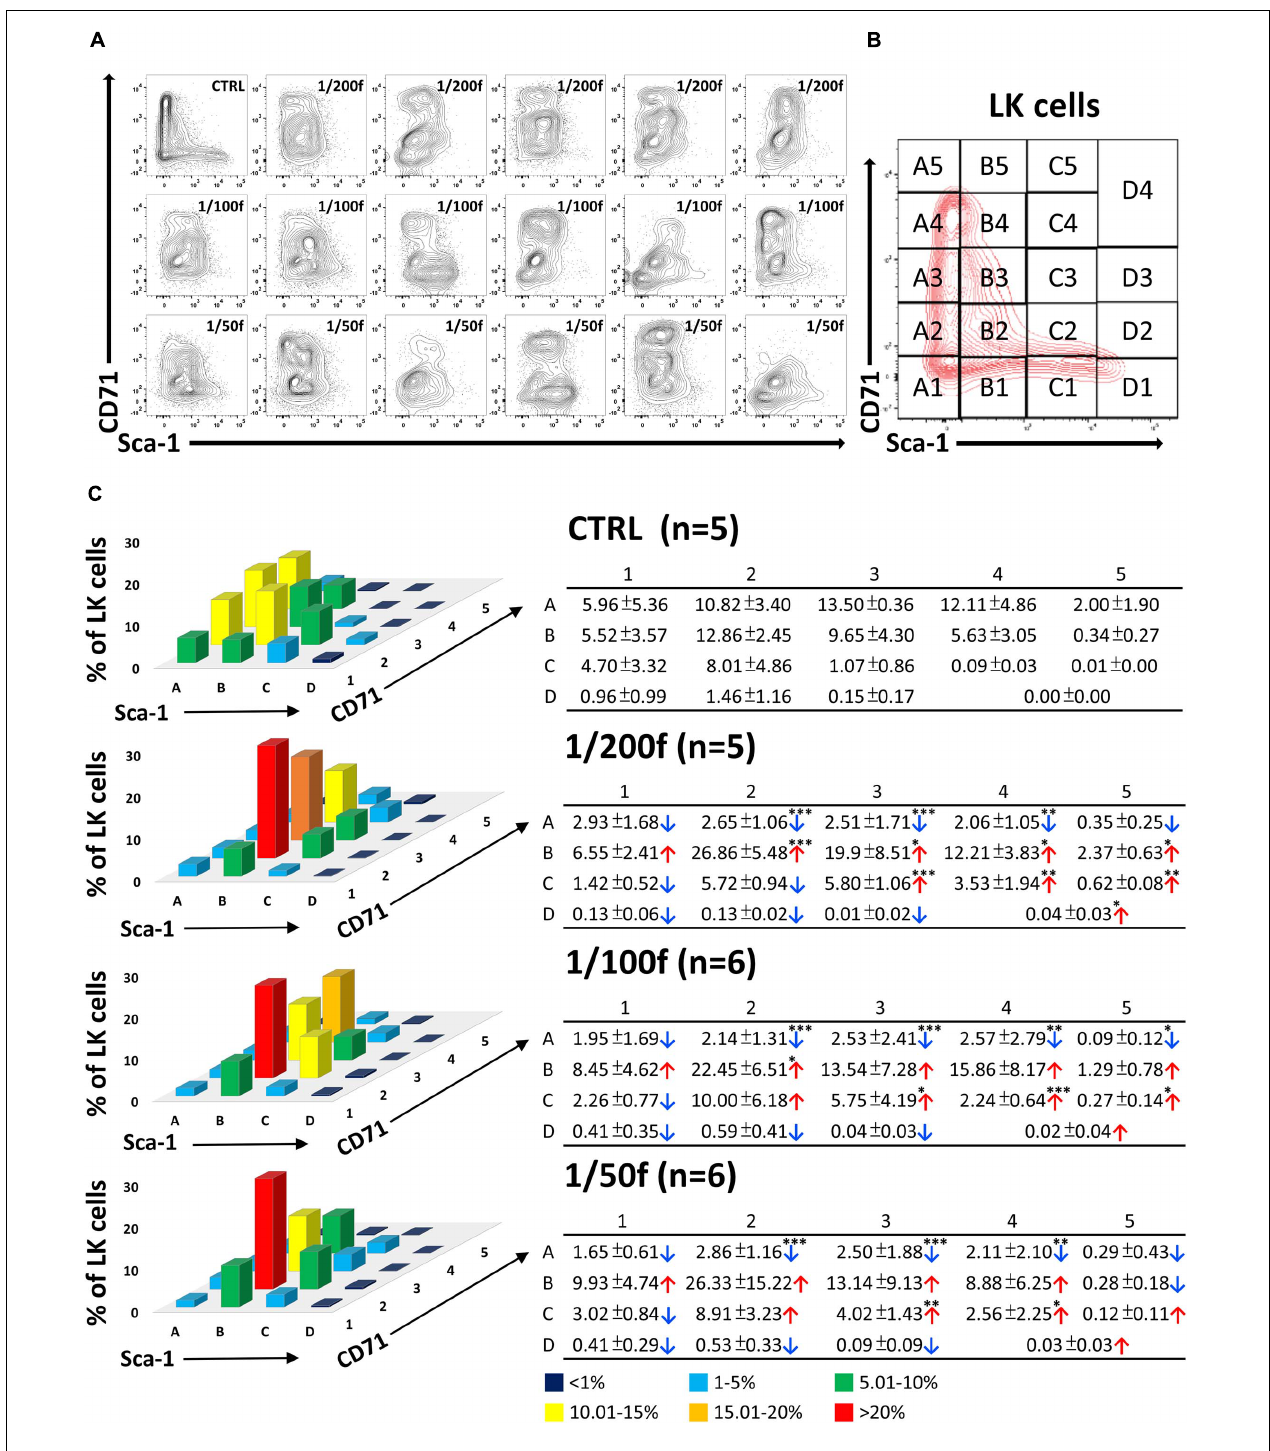
FIGURE 2 | Immature hematopoietic cells derived from transplanted bone marrow have altered immunophenotype in intensively regenerating bone marrow. In two independent experiments, C57Bl/6 female mice irradiated at 9 Gy were transplanted with syngeneic bone marrow corresponding to 1/200 (five mice), 1/100 (six mice), and 1/50 (six mice) of the femoral bone marrow (male). Five untreated mice were left as controls (CTRL; two females and three males). Two weeks after transplantation, LK cells in bone marrow were analyzed to express Sca-1 and CD71 markers (A) . The CD71/Sca-1 plot of LK cells was divided into 19 parts (B) , and the percentage of LK cells was determined in them. The mean occurrence of cells in various parts of the CD71/Sca-1 plot is graphically shown as the mean values ± SD in accompanying tables (C) . Tables show significantly changed cell numbers in some zones of CD71/Sca-1 plot in transplanted mice. ∗ p < 0.05, ∗∗ p < 0.01, ∗∗∗ p <